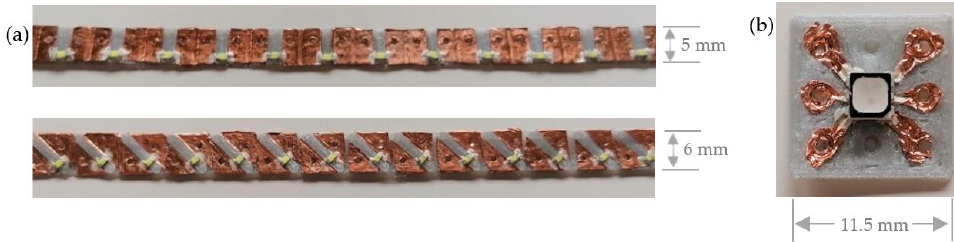
12 of 20 Figure 11. Single-layer sequin designs for ( a ) LED sequins designs and ( b ) RGB sequins. Three different 3D printing concepts are used to print the 3D sequins. The first con- cept is based on the 3D printing of a sequin made of PLA and the creation of the conductor structures using copper adhesive tape. In the second concept, the sequin carrier is printed from PLA. With the second nozzle of the dual 3D printer, a mask is printed on the sequin carrier with a water-soluble PVA filament. The unmasked areas are metallized with gold in a sputtering process. In the third concept, the sequin carrier is made of PLA and the conductor structures are printed with the conductive plastic filament Electrifi by using dual 3D printing.